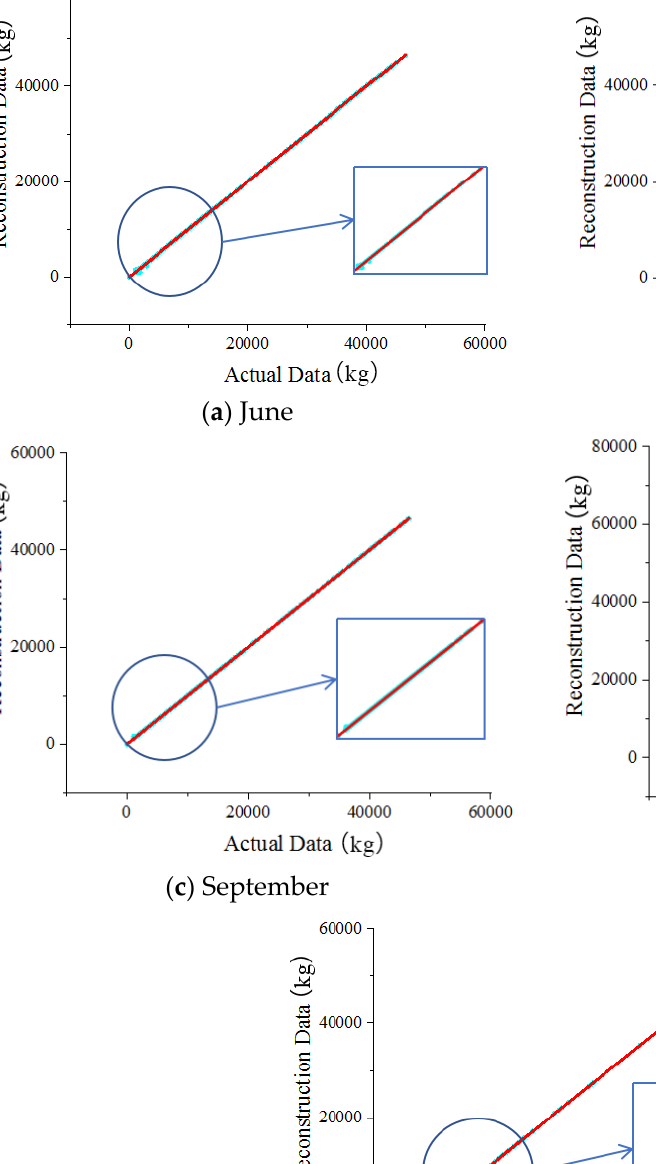
Figure 7. The training error for the generator network. To better represent the usability of the GAN, this paper used the reconstruction meth- ods described in the introduction to reconstruct the traffic flow data from the Hangzhou Jiangdong Bridge and compared the RMSE values of the datasets that were generated by the GAN model using these methods. These methods were selected because they can be used for the reconstruction of time series data, which is similar to the goal of the comple- tion of the time series dataset for the bridge WIM system in this paper. The results are presented in Table 3. 0